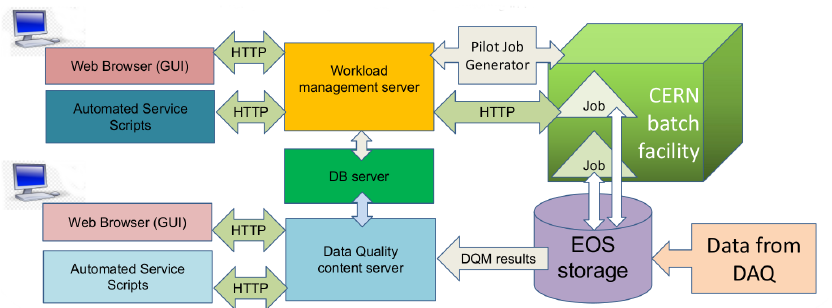
Figure 1. The protoDUNE-SP prompt processing and DQM systems